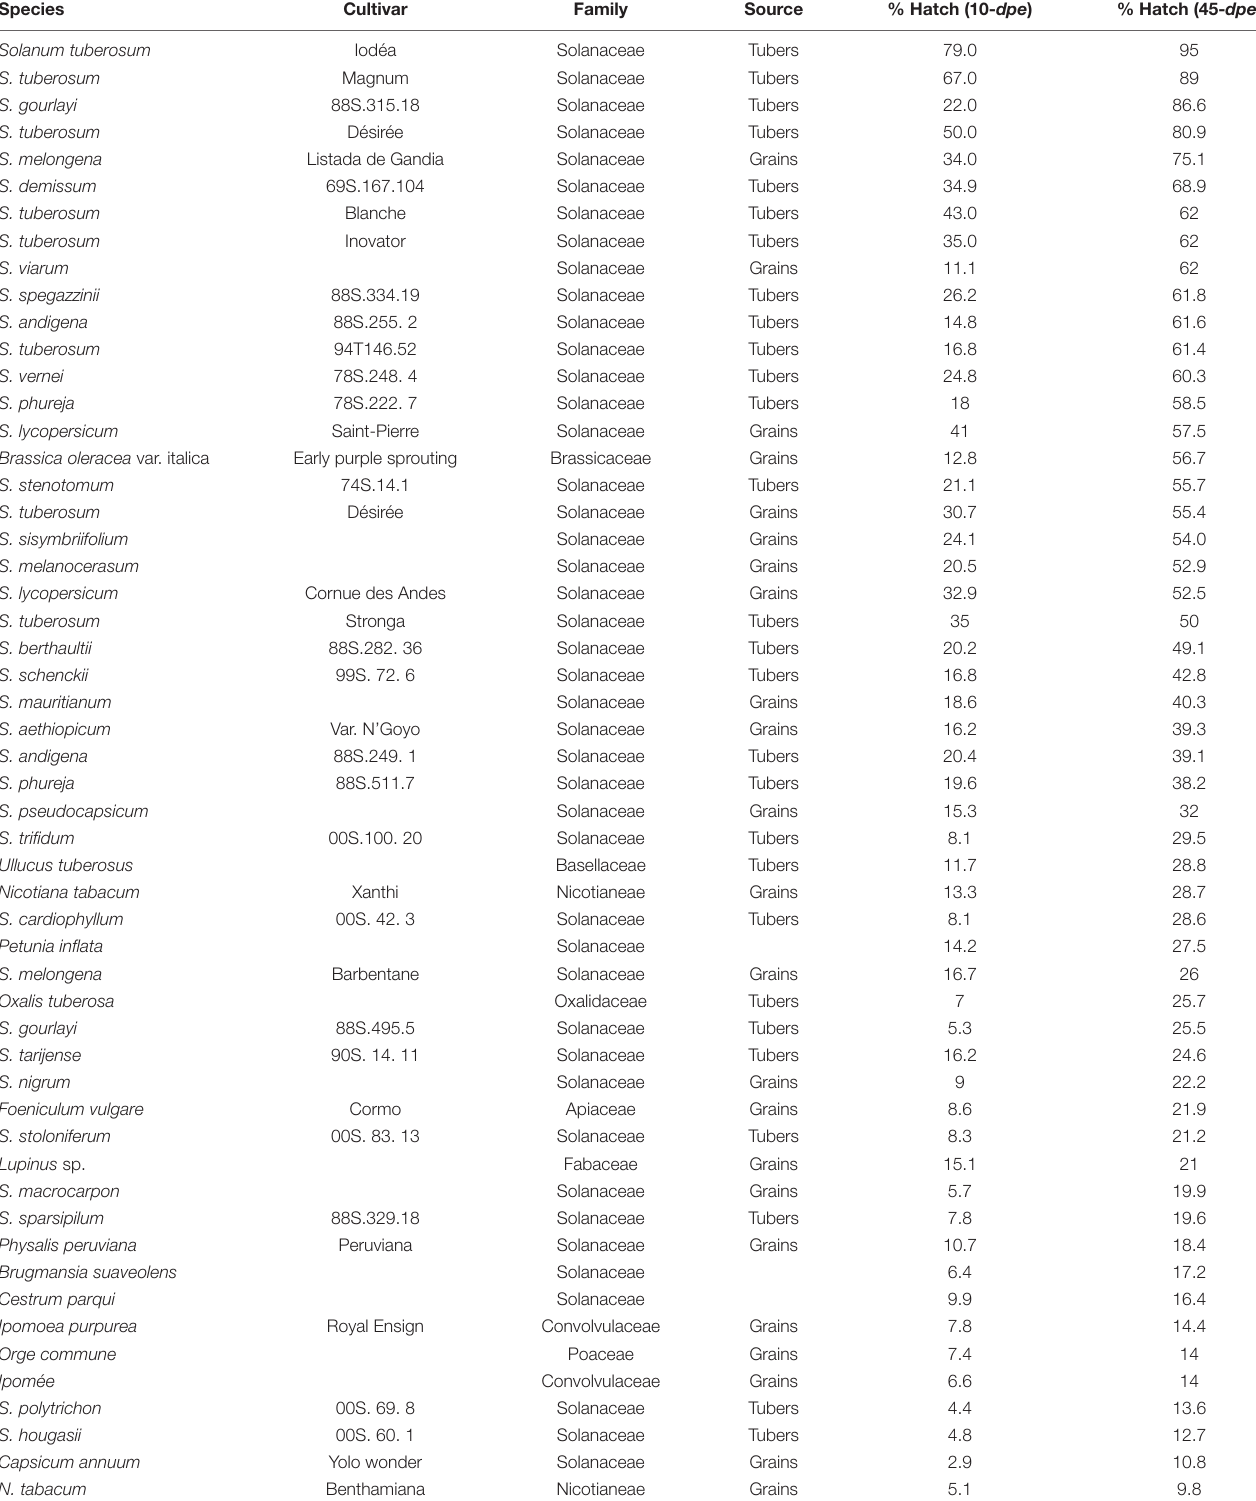
TABLE 1A | Plant species and/or cultivars screened for the ability of their root exudates to induce hatching of Globodera pallida in vitro. Species Cultivar